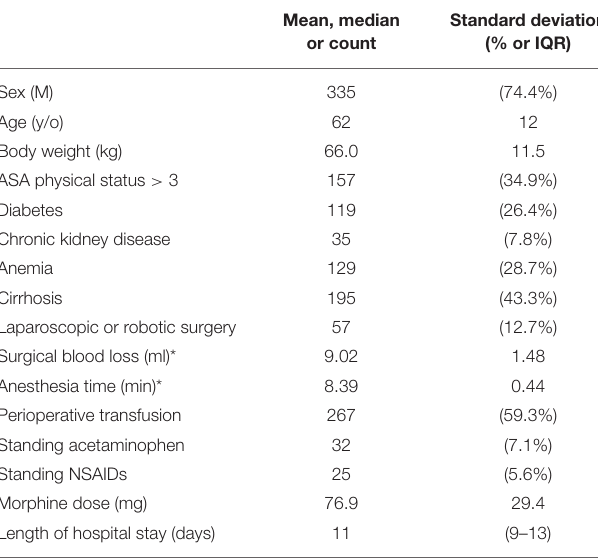
TABLE 1 | Patient characteristics.